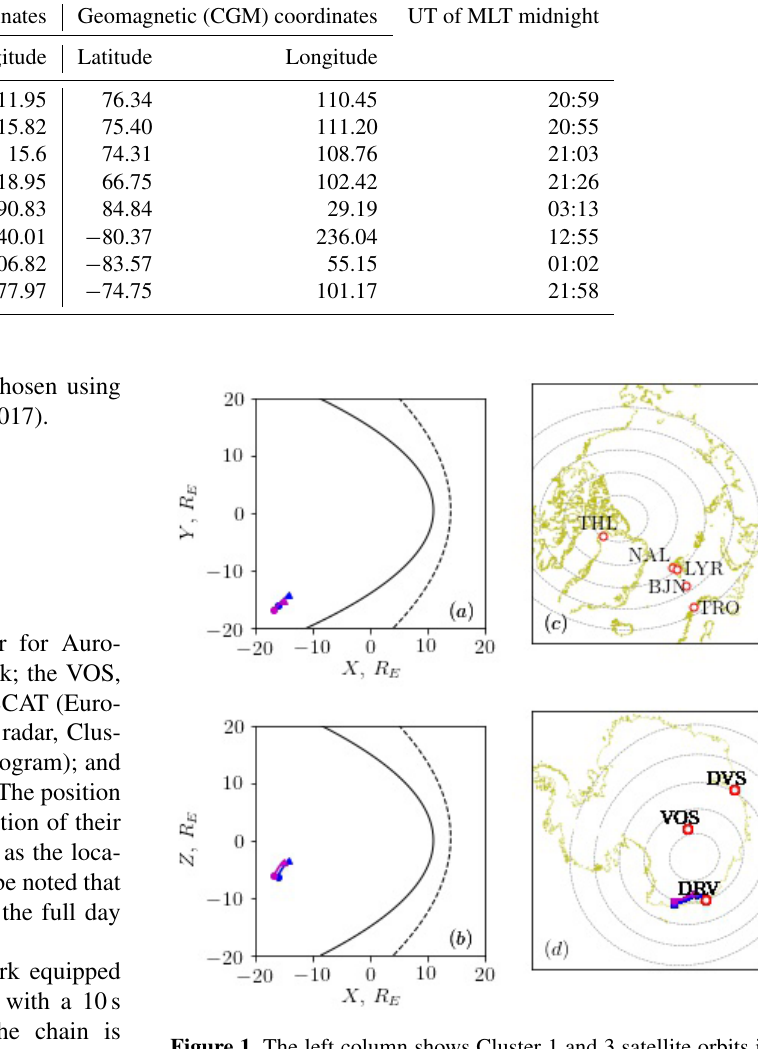
Figure 1. The left column shows Cluster 1 and 3 satellite orbits in GSE coordinates ( XY – panel a , XZ – panel b ), and the right col- umn shows their projection on the map with observatories located in the (c) Northern and (d) Southern hemispheres (12:00–18:00UT). The initial point and final point are marked with a circle and a tri- angle